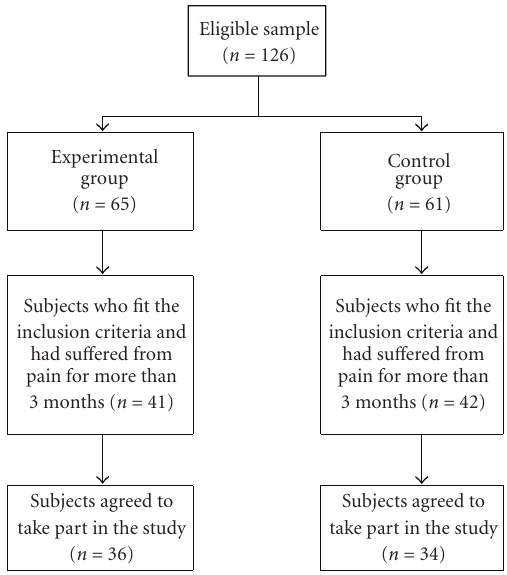
Figure 1: Summary of the workflow of the